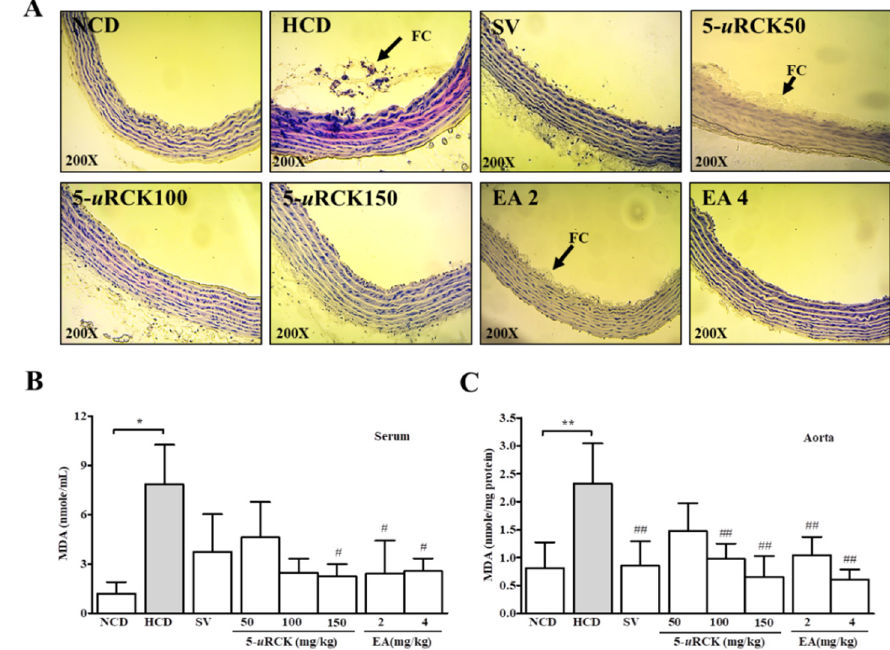
Figure 6. Photomicrographs of H and E-stained abdominal rat aortas after different treatments for 5 weeks ( A ). Effect of dietary supplementation with 5- u RCK or ellagic acid on serum ( B ) and aortic ( C ) malondialdehyde (MDA) levels in HCD-fed rats. The arrows point to foam cells (FC). * p < 0.05, ** p < 0.01, versus the control (NCD) group, # p < 0.05, ## p < 0.01, ### p < 0.001 versus the HCD group. All data are shown as the mean ± SD ( n = 6–8).